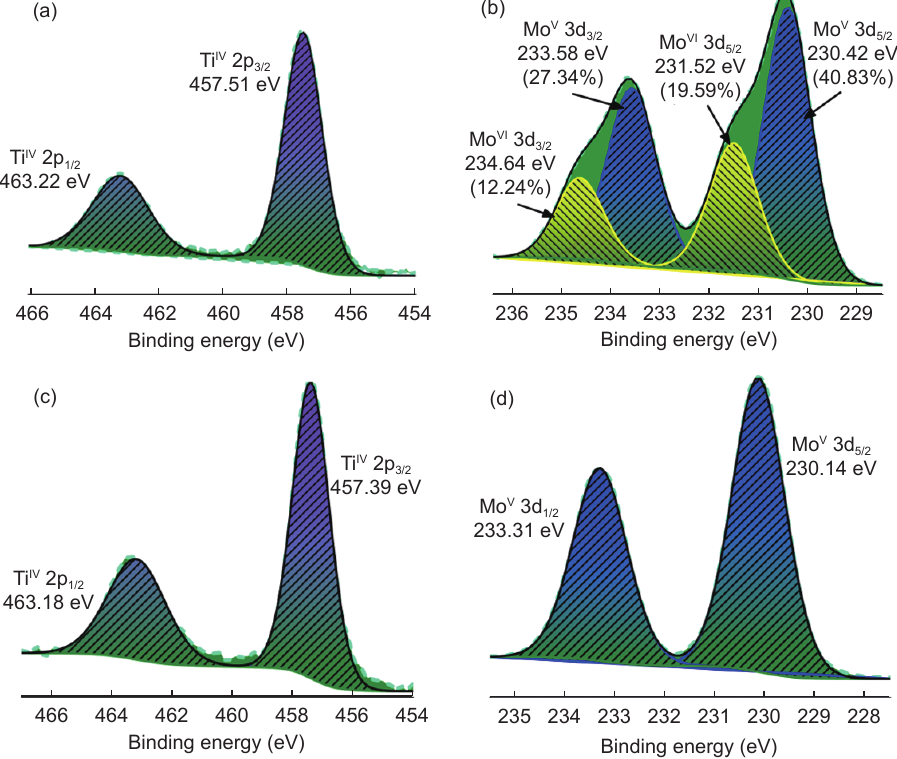
Figure 3 (a) and (b) Ti IV and Mo V/VI XPS signals of 1 . (c) and (d) Ti IV and Mo V XPS signals of 2